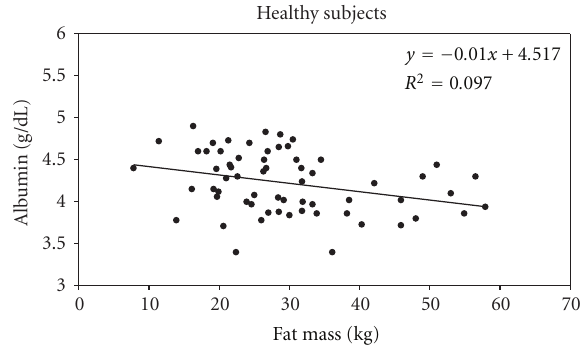
Figure 4: Representative immunoblot shows the albumin expres- sion in Om and Sc adipocytes and preadipocytes isolated from a noninflamed control. Actin was used as loading control.